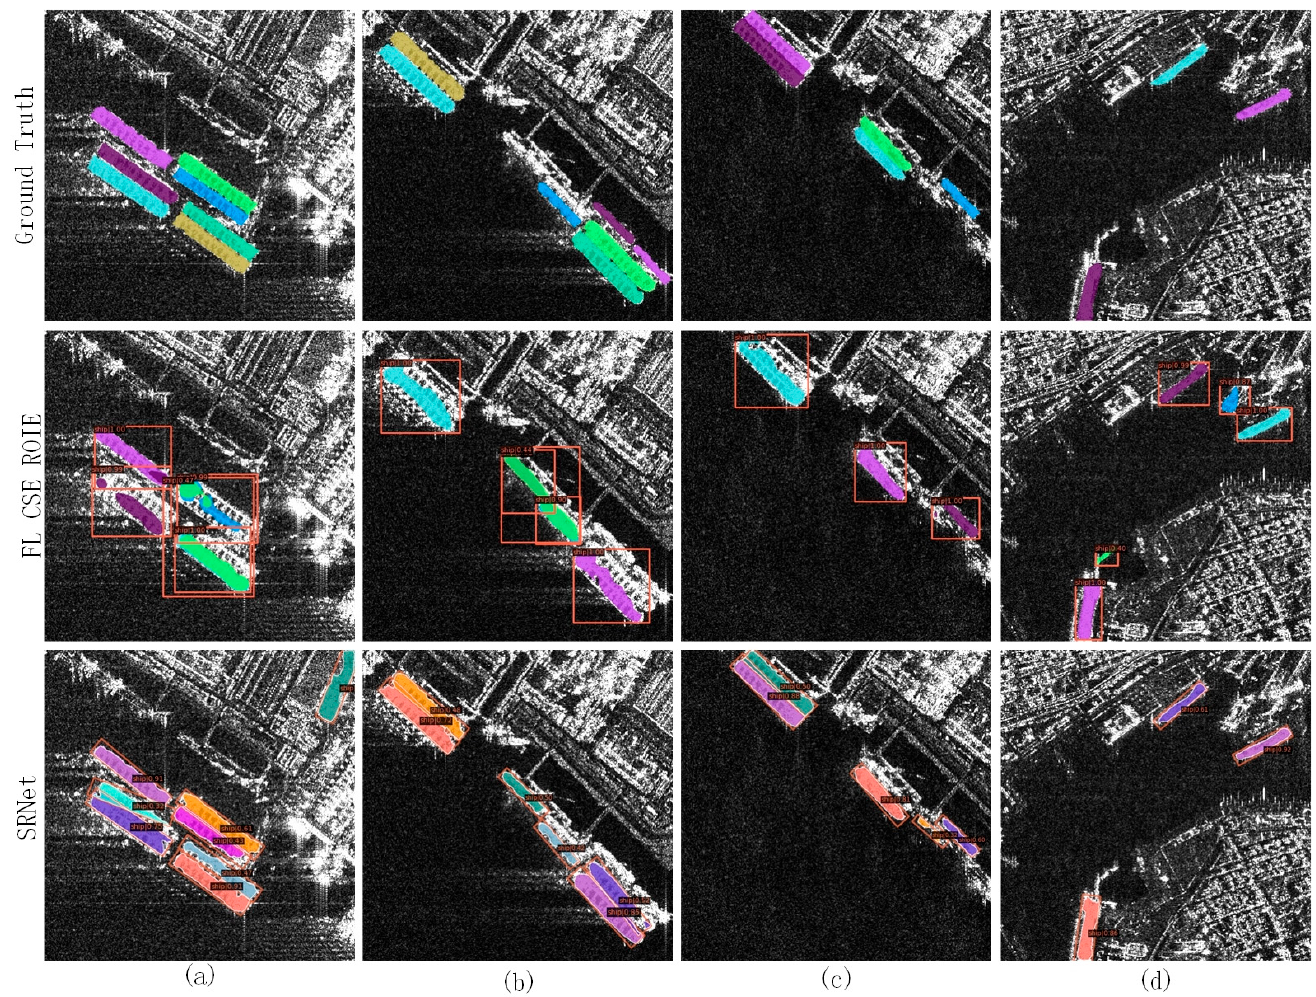
Figure 15. Four visualization illustration images of different comparison networks for instance seg- mentation on the Instance-RSDD dataset. ( a – d ) The scenes of the ships berthing in the